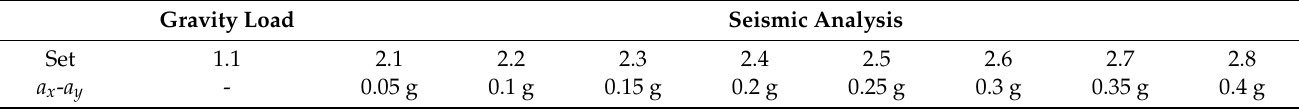
Table 10. Acceleration values associated with the different analysis